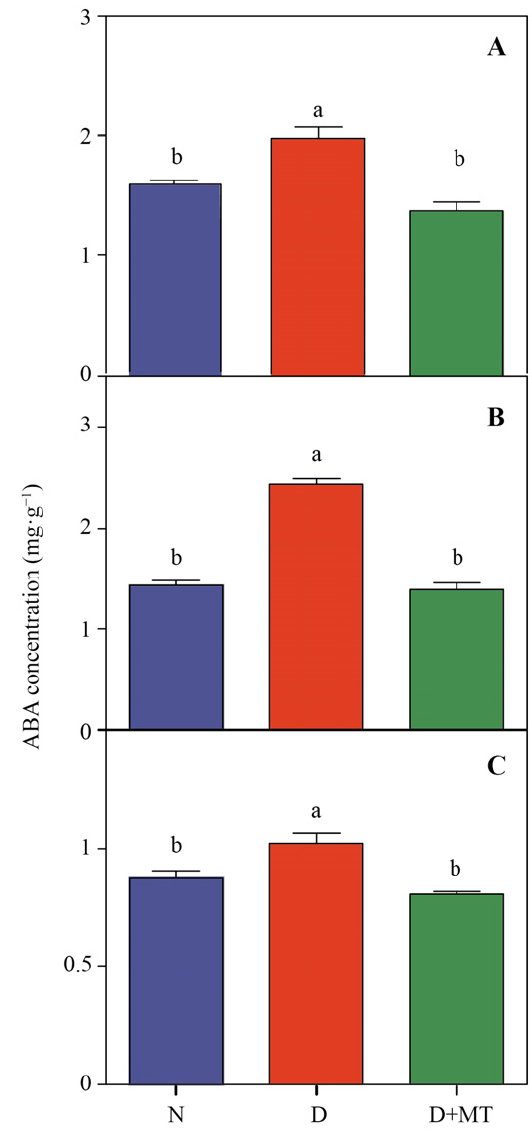
Figure 3. Concentrations of ABA in soil, barley root, and leaf as affected by melatonin treatment and drought stress. The letters ( A – C ) corresponds to leaves, roots, and soil, respectively. Data are reported as mean ± SE ( n = 4). Different small letters indicate significant differences at the p < 0.05 level. N, normal control; D, drought stress; D + MT, melatonin + drought stress.